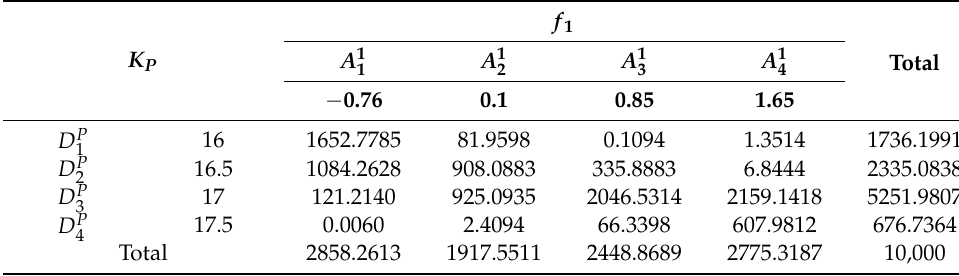
Table 6. The casting results of sample pairs ( f 1 , K P ).